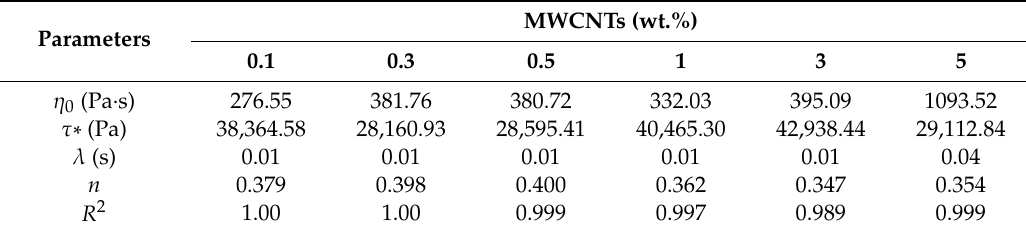
Figure 9. Viscosity master curves at a reference temperature of 130 ◦ C, and predictions (solid lines) by the Cross model. Table 3. Cross parameters for master curves at a reference temperature of 130 ◦